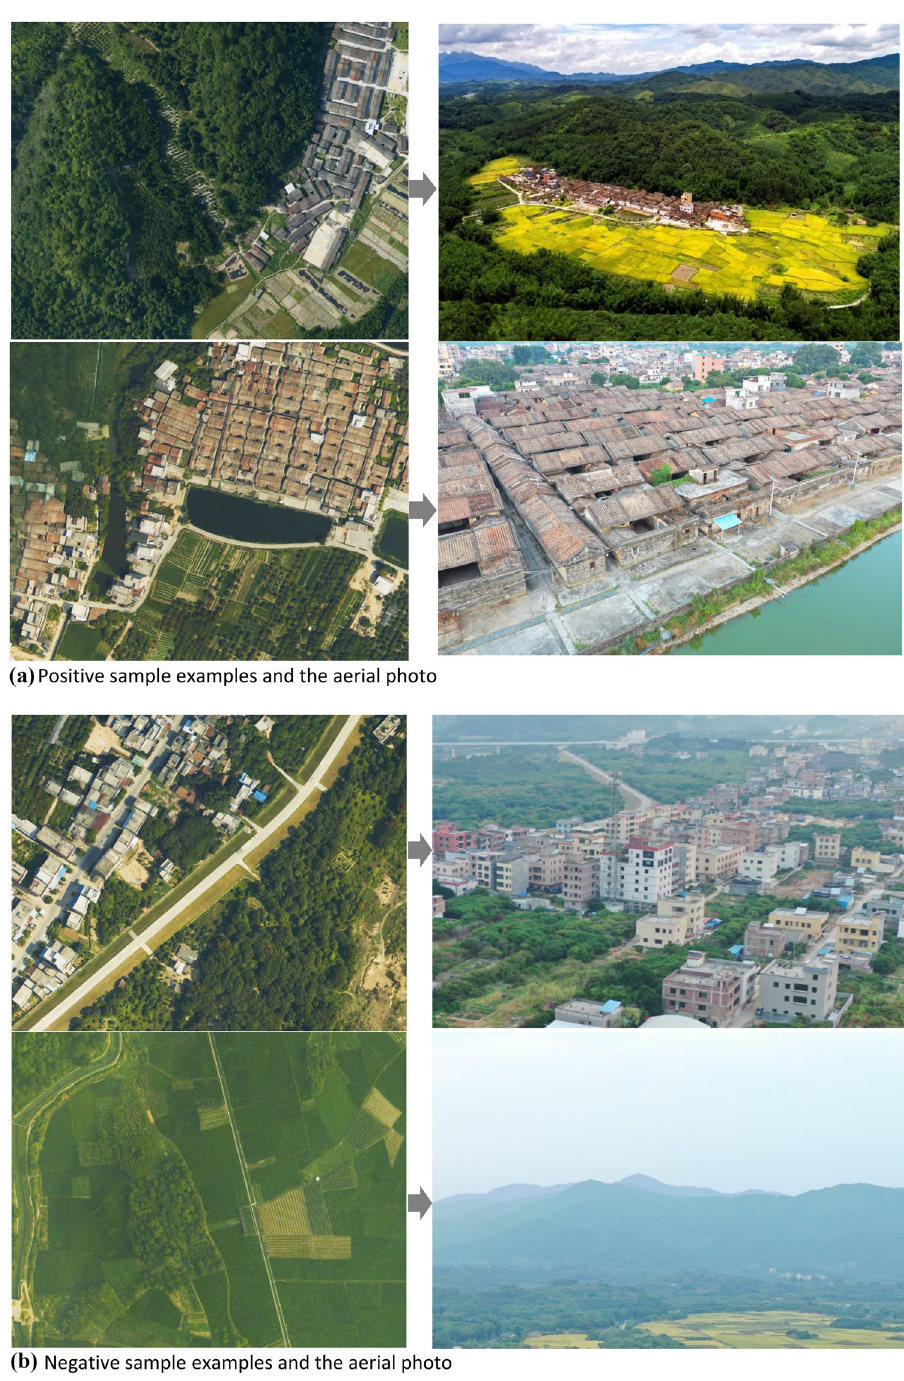
Fig. 4 Examples of a classifica- tion task